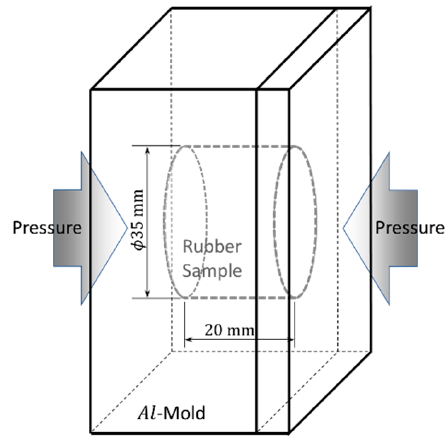
Figure 1. Mold for thick rubber production.